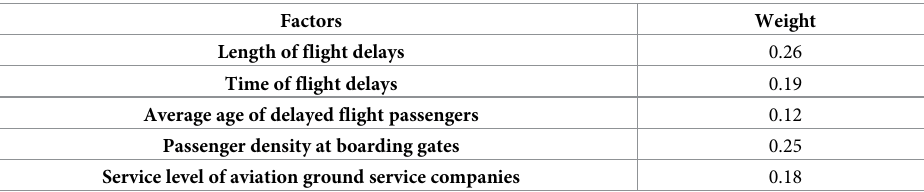
Table 11. Weight of factors for flight delay passenger behavior